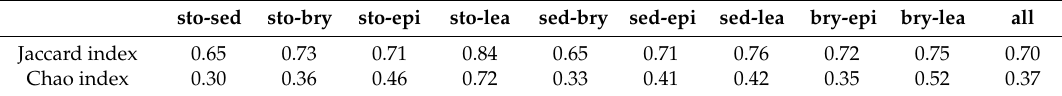
Table 2. Mean compositional turnover between di ff erent microhabitats within springs measured using the Jaccard index and the abundance corrected Chao index. Microhabitats: all = all microhabitats within a spring, bry = bryophytes, sto = stones, sed = sediment, lea = leaf litter, epi = epiphytic on filamentous green algae. sto-sed sto-bry sto-epi sto-lea sed-bry sed-epi sed-lea bry-epi bry-lea